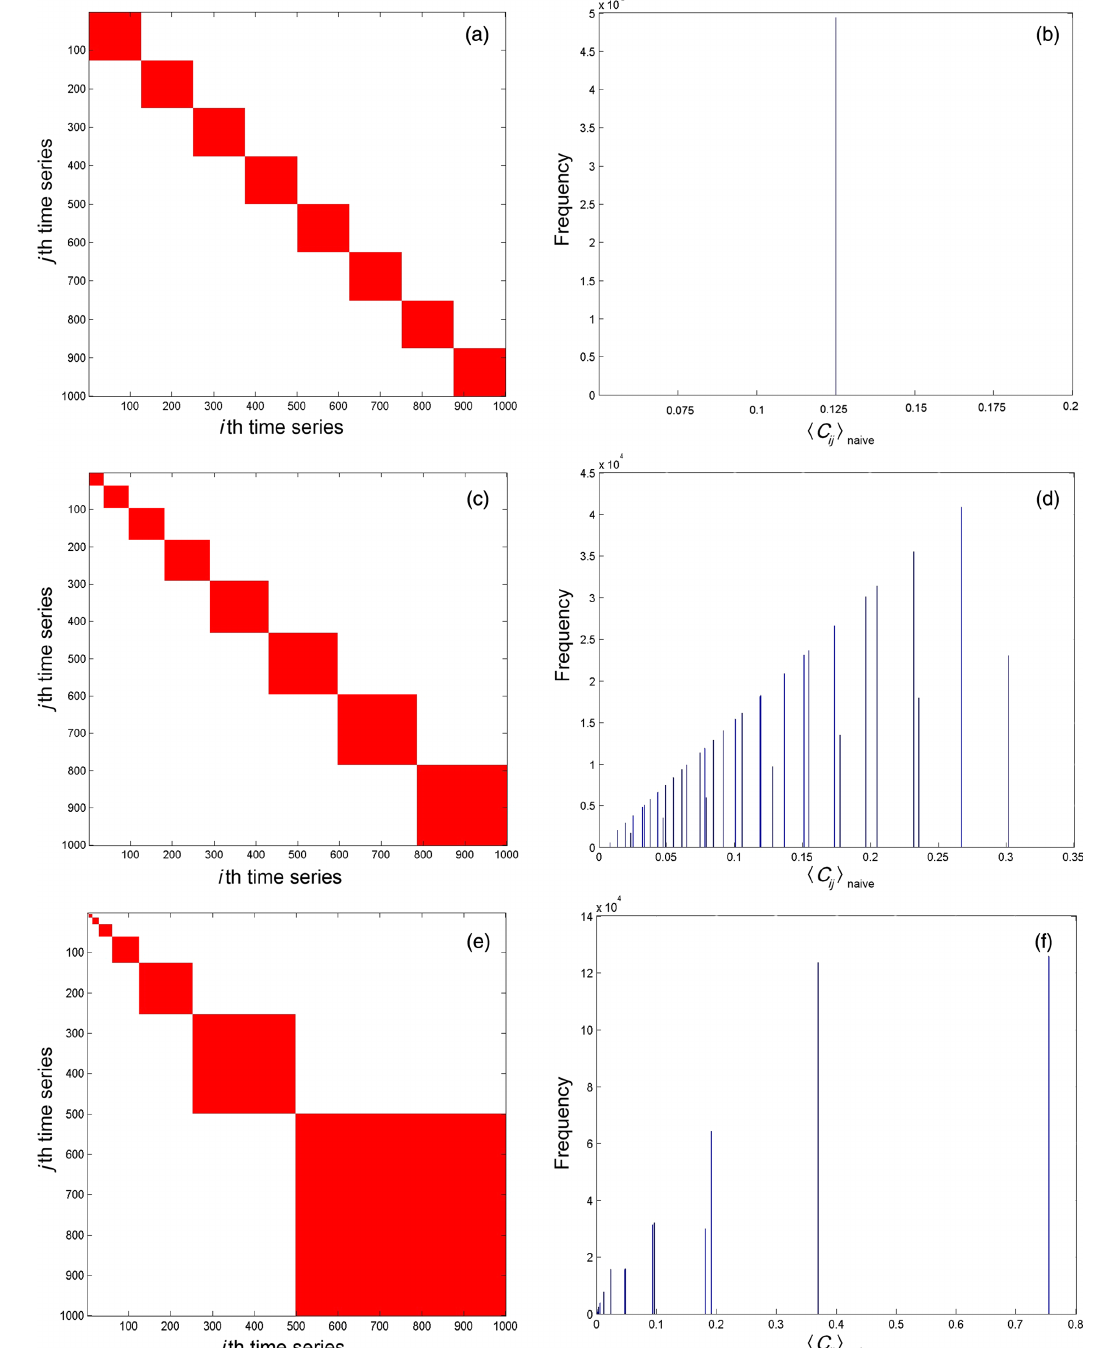
FIG. 2. The biasing effect of the heterogeneity of community size on the naive (network-based) modularity. The left panels show the entries δ ð σ (cid:4) ; σ (cid:4) Þ of three benchmark community matrices (white ¼ 0 , red ¼ 1 ), each with N ¼ 1000 time series and c ¼ 8 communities of i j increasingly heterogeneous sizes. The right panels show the corresponding distribution of the off-diagonal entries h C of the null model ij i naive defined in Eq. (32), with ϕ ¼ 1 (the bin size of the histograms is of the order of 10 − 5 , which makes the distributions correctly normalized). For perfectly homogeneous community sizes, i.e., if each community contains exactly 125 time series (a), the distribution has a single peak at 1 =c ¼ 0 . 125 (b).Formoderatelyheterogeneoussizes,i.e.,iftheeightcommunitiescontain35,60,85,110,140,165,190,and215timeseries, n σ (cid:4) in Eq. (32). For strongly respectively (c), the distribution has several peaks (d) coming from the 64 different combinations of n σ (cid:4) i j heterogeneoussizes,i.e.,iftheeightcommunitiescontain4,8,16,32,64,128,246,and502timeseries,respectively(e),thedistributionstillhas 0 . 7536 (coming from pairs of time series inside 64 different peaks but is much broader (f). The two dominant peaks are located at h C ij i naive ¼ 0 . 3694 (coming from pairs of time series across the largest and the second-largest the largest community) and h C ij i naive ¼